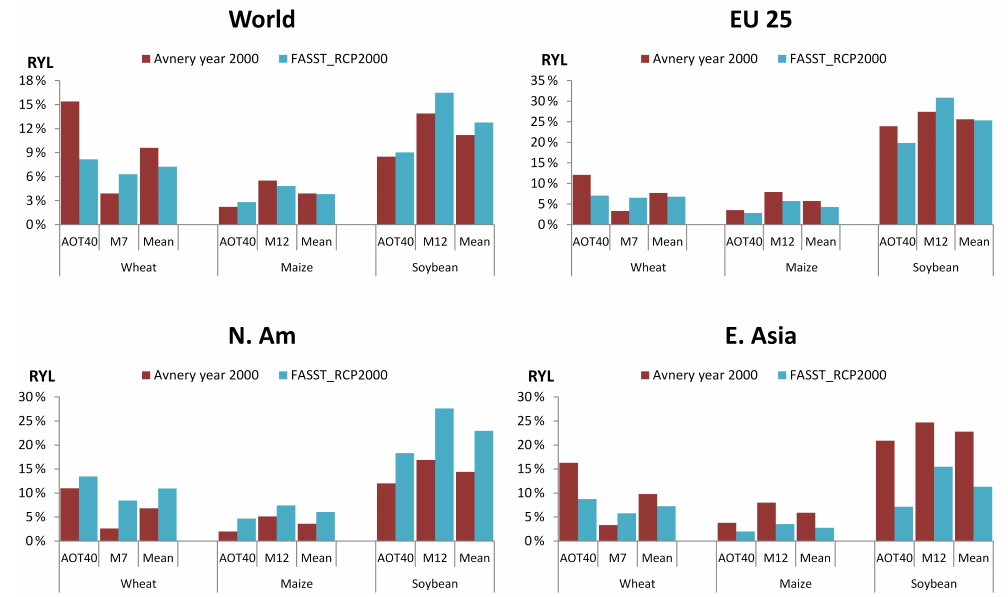
Figure 18. Year 2000 global and regional ozone-induced relative yield losses in four world regions for three major crops, from Avnery et al. (2011) and from TM5-FASST (RCP year 2000), estimated from the two common exposure metrics M7 and AOT40 (see text), as well as the mean of